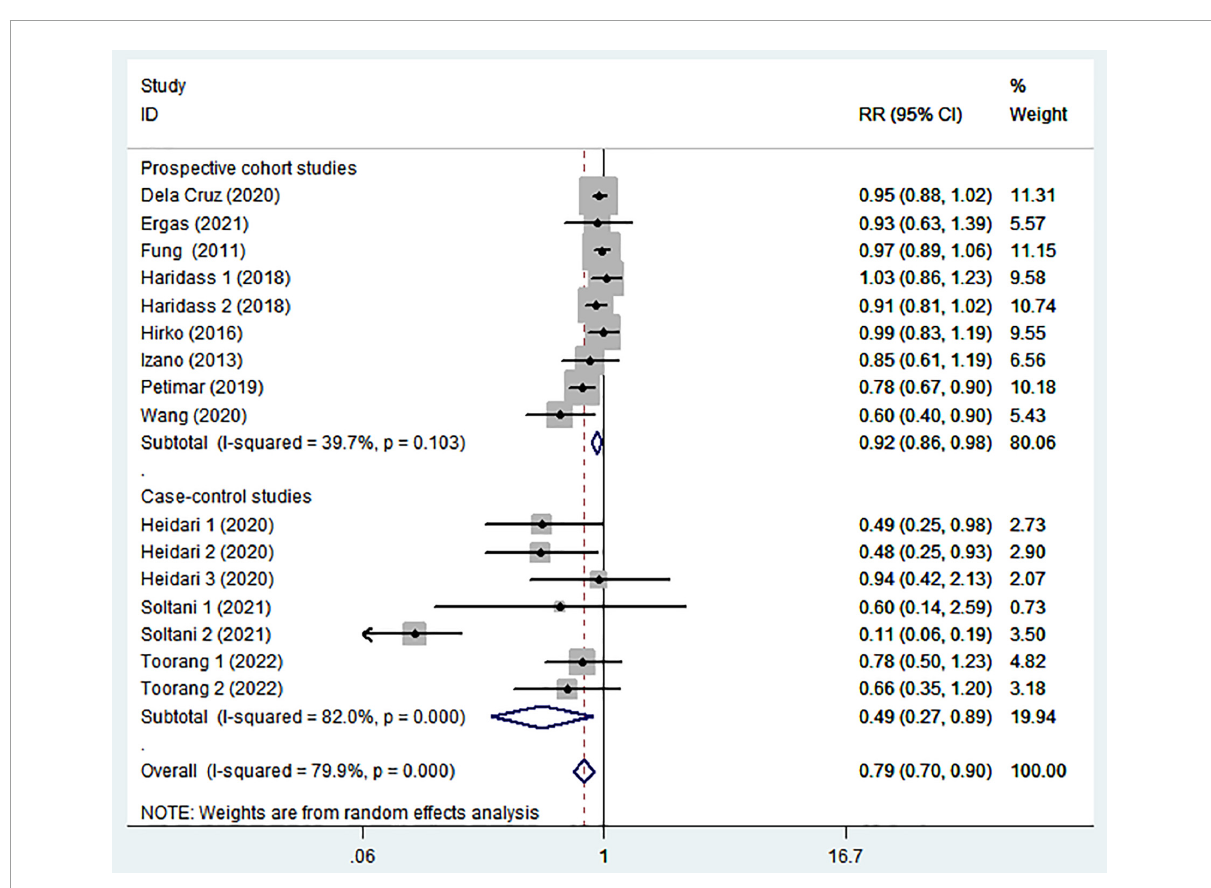
FIGURE3 Meta-analysis on the association between adherence to dietary approaches to stop hypertension (DASH) diet and breast cancer risk stratified by studied design.